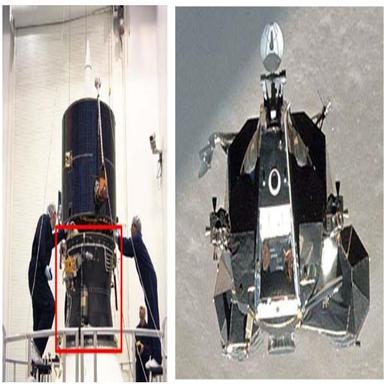
Left panel: the Lunar Prospector spacecraft with its Trans-Lunar Injection Stage (TLIS) framed within the red box. Picture is courtesy of NASA and it is publicly available at the URL: (http://images.ksc.nasa.gov/photos/1997/high/KSC-97PC-1806.jpg) Right panel: the Lunar Module LM-4 ''Snoopy" of the Apollo 10 mission. The picture was taken on May 23, 1969, with ''Snoopy" in its course from the Moon to dock again with the Command Module ''Charlie Brown". Picture is courtesy of NASA and it is publicly availab